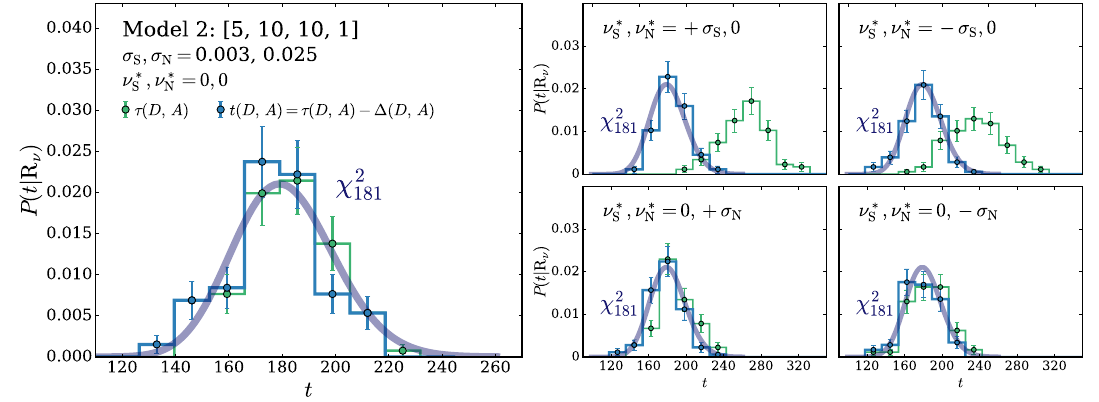
Fig. 16 Same as Fig. 15, but for the electron-like